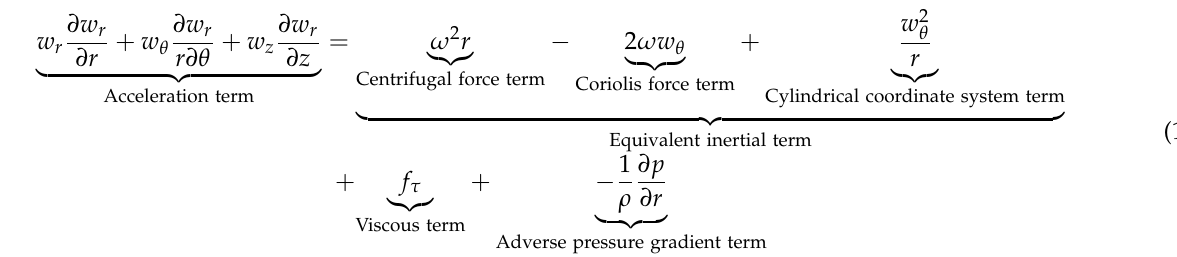
where w represents the relative velocity, the subscripts r , θ , and z represent the radial, circumferential, and axial directions, respectively, ω represents the angular velocity, and ρ represents the density. The three terms on the left side of the above expression are acceleration terms. On the right side, the first term is the adverse pressure gradient term, the second term is the centrifugal force term, the third term is the Coriolis force term, the fourth term stems from the cylindrical coordinate system, and the fifth term is the viscosity term. Furthermore, the second and third terms on the right side are inertial force. In terms of the expression, the fourth term can be equivalent to the centrifugal force. Therefore,